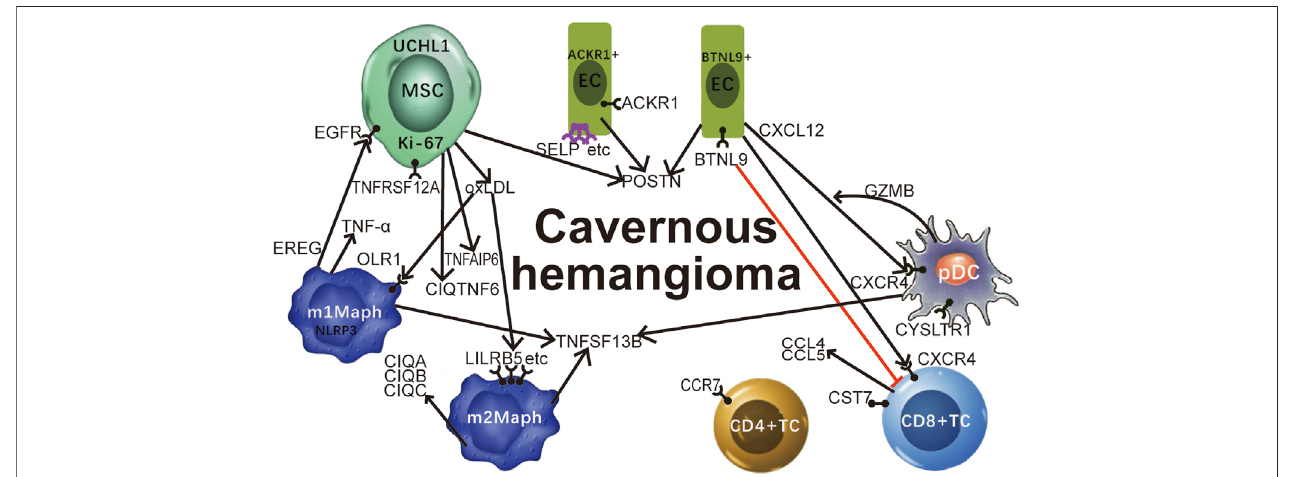
FIGURE 4 | Featured genes and pathways in cavernous hemangiomas. Proin fl ammatory cytokines and related genes TNF (encoding TNF- α ), TNFSF13B , TNFRSF12A , TNFAIP6 , and C1QTNF6 are signi fi cantly involved in the MSC-induced immune responses in cavernous hemangiomas; The MSCs in cavernous hemangioma exhibit characteristics of tumours, e.g., high expression of GAPDH and very high expression of MKI67 (encoding Ki-67). UCHL1 can be used as a marker gene to detect embryonic MSCs at different apoptosis stages. The highly expressed EREG in M1-like macrophages interacted with the highly expressed EGFR in MSCsmaycauseMSCproliferationandthetumourprogressionthroughthebindingof EREG to EGFR .MSCsinducedtheresponsesofACKR1positiveendothelialcells (ACKR1+ECs) and BTNL9 positive endothelial cells (BTNL9+ECs). Adhesion molecules including SELP , SELE , and VCAM1 were up-regulated leading to leukocyte transmigrationacrosstheendotheliumtothesiteofin fl ammation. POSTN wasexpressedatveryhighlevelsinMSCs,highlevelsintheEC2cluster,andmediumlevelsin the BTNL9+EC and ACKR1+EC. CCR7 has the potential to be a new marker to discriminate the CD4+T cells from the activated CD8+T cells. CST7 was unexpectedly detected to be expressed at high levels in activated CD8+T cells, medium levels in NK cells, and barely detected in non-immune cells. CD8+T cells and NK cells may highly express CCL5 for their in fi ltration in cavernous hemangiomas, independent on the tumour cell-derived CCL5-IFNG-CXCL9 process. The ligand-receptor interactionsbetween CXCL12 andCXCR4 play ansigni fi cantrolein theimmune responsesin cavernous hemangioma. Thehighly expressed BTNL9 inBTNL9+ECmay cause checkpoint blockade through the binding of BTNL9 to T-cells. The highly co-expression of CXCR4 and GZMB suggested that pDCs function for anti-tumour as CD8+Tcells.WeproposethatOxLDLinducestheOxLDL-OLR1-NLRP3processinM1-likemacrophagesviatheover-expressionof OLR1 ,whereasOxLDLinducesthe OxLDL-SRs-C1q process in M2-like macrophages via the over-expression of many SR genes ( LILRB5 , etc) except OLR1 . MSC: mesenchymal stem cell; OxLDL: oxidised low-density lipoprotein; SR: scavenger receptor; TNF: tumour necrosis factor.